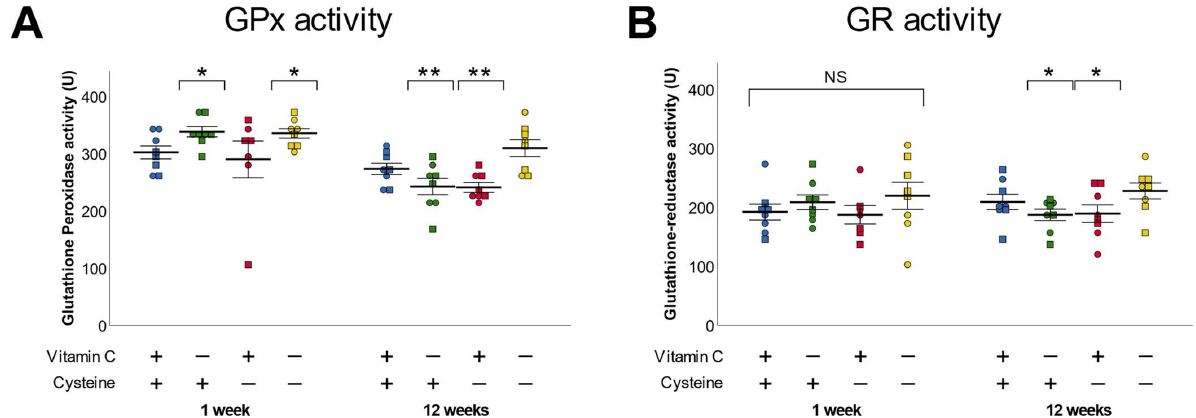
Figure 4. Activity of glutathione peroxidase (GPx) and reductase (GR) in liver of 1-week- and 12-week-old animals. ( A ). GPx activity was increased in vitamin C deficient animals at 1 week of life ( p < 0.05). At 12 weeks, early-life vitamin C and cysteine single deficiencies decreased GPx activity. ( B ). No statistically significant differences were observed in GR activity at 1 week of life. At 12 weeks, both neonatal vitamin C deficiency and cysteine deficiency decreased GR activity. Mean ± SEM. Circles: male animals; squares: female animals; NS: statistically non-significant; *: p < 0.05, **: p < 0.01 . At 1 week of life, only the activity of PFK was increased by vitamin C and cysteine deficiencies (Figure 5B). However, specific activities of GCK and PFK were increased by